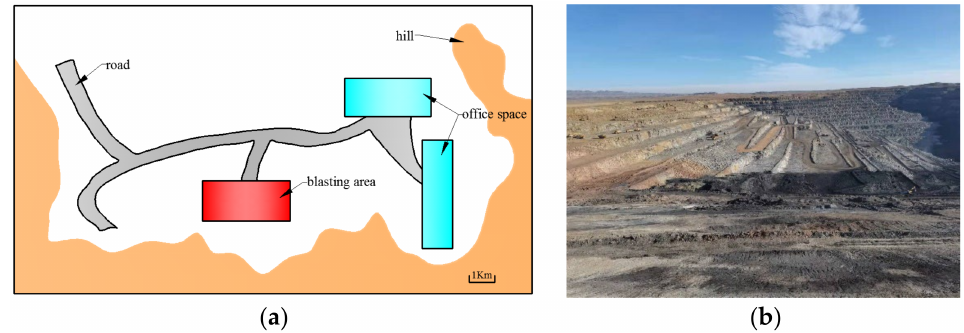
Figure 4. Chart of blast zone environment. ( a ) Explosion area location. ( b ) Field